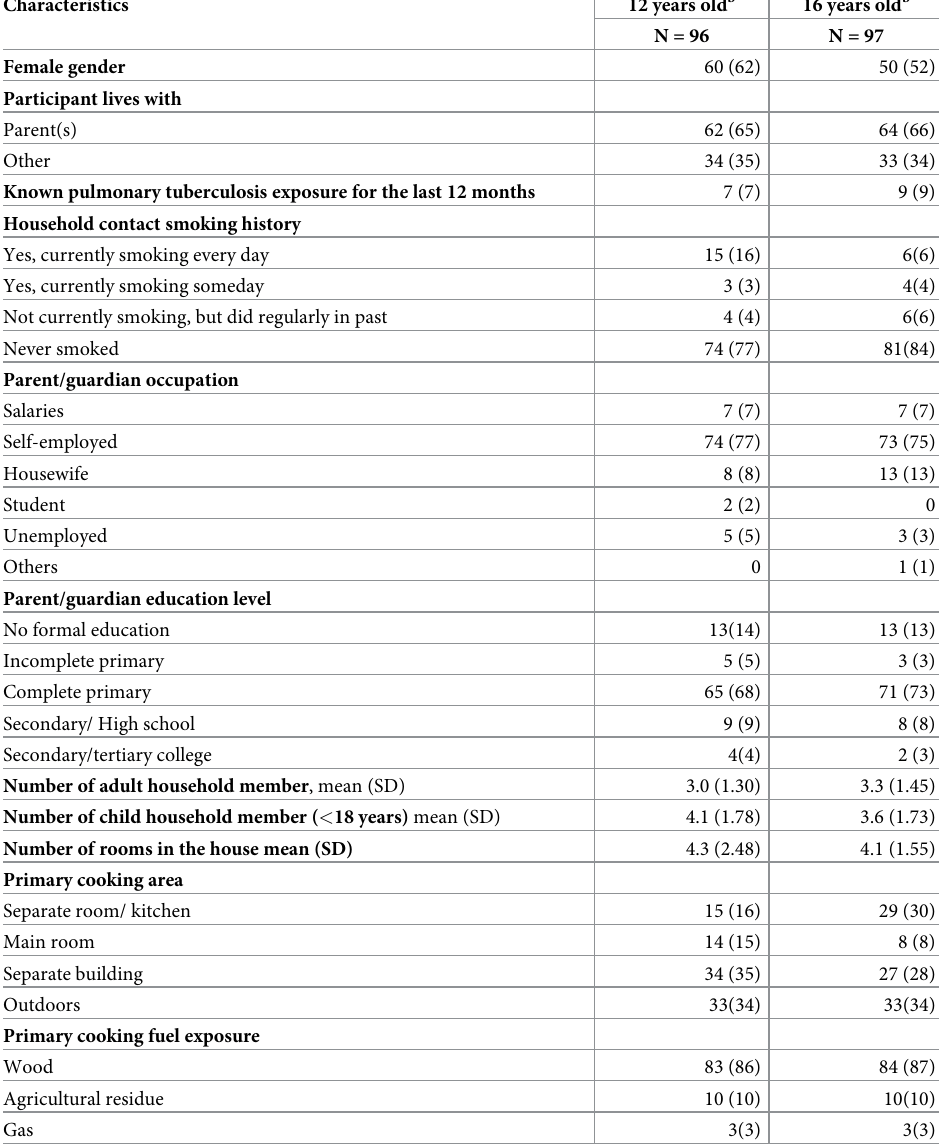
Table 1. Demographic and baseline characteristics of 193 adolescent assessed for latent tuberculosis infection a . Characteristics